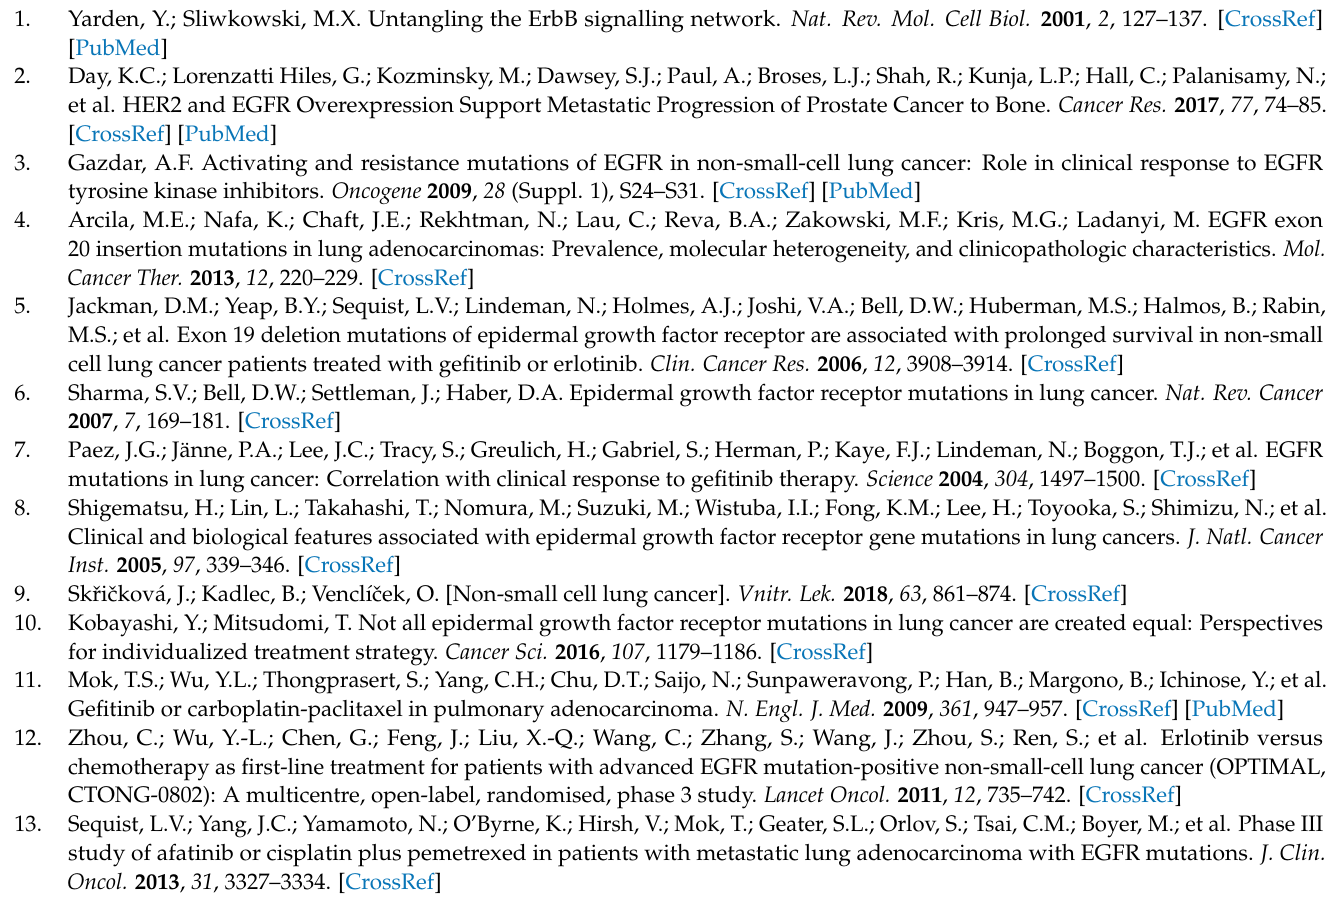
with important regions highlighted. Figure S3: The flexibility of EGFRs during the simulations. Figure S4: The hydrogen-bond interactions contribute to the stability of the α C-helix. Figure S5: The hydrogen-bond interactions introduced by the co-occurring mutated residue. Figure S6: Contact map between IRE and EGFR in the three IRE-bound systems. Table S1: The full names and abbreviations of amino acids in this work. Table S2: The full names and abbreviations of nouns in this work. Movie